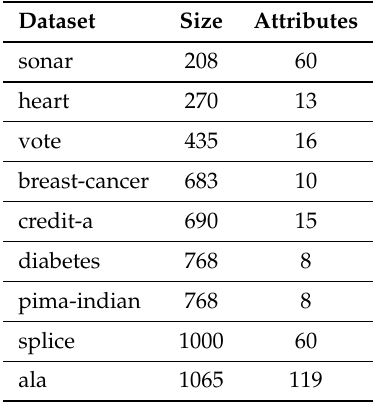
Table 1. Binary datasets in the experiment.